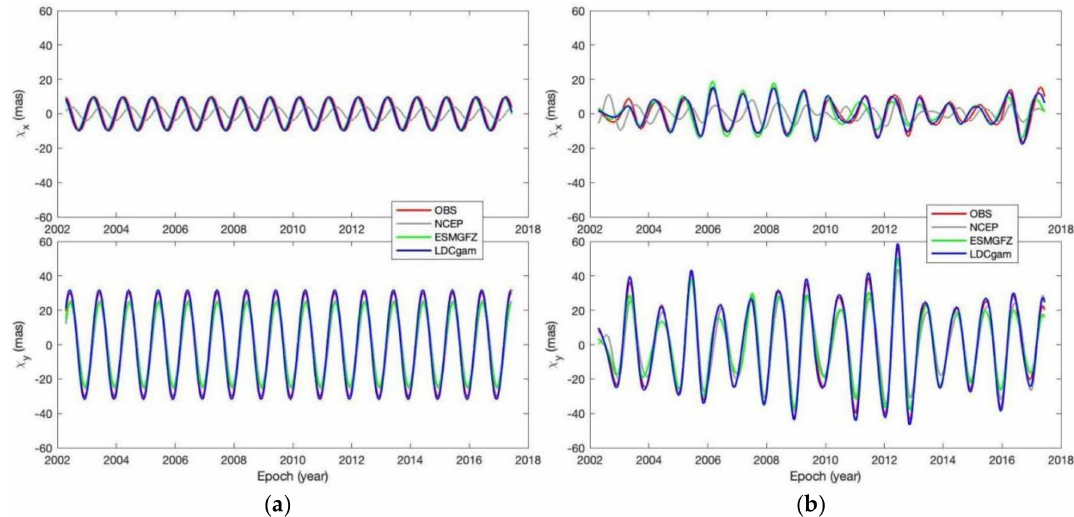
Figure 6. Annual PM excitations. ( a ) Harmonic fitting according to Equation (2); ( b ) wavelet analyses based on the coif5 wavelet, as shown in Figure 4.